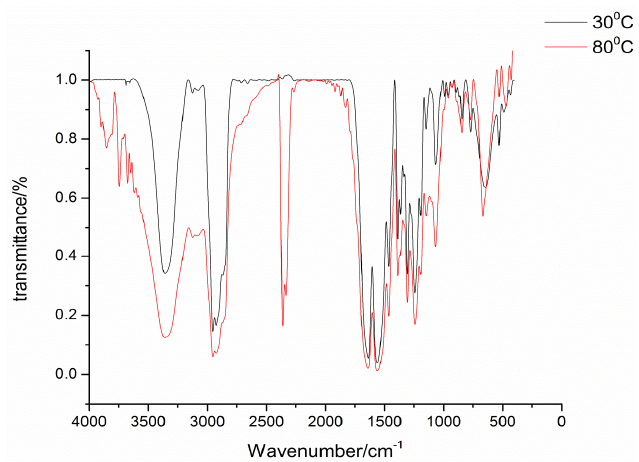
Figure 1. FTIR spectra of blocked isocyanates at different temperatures.